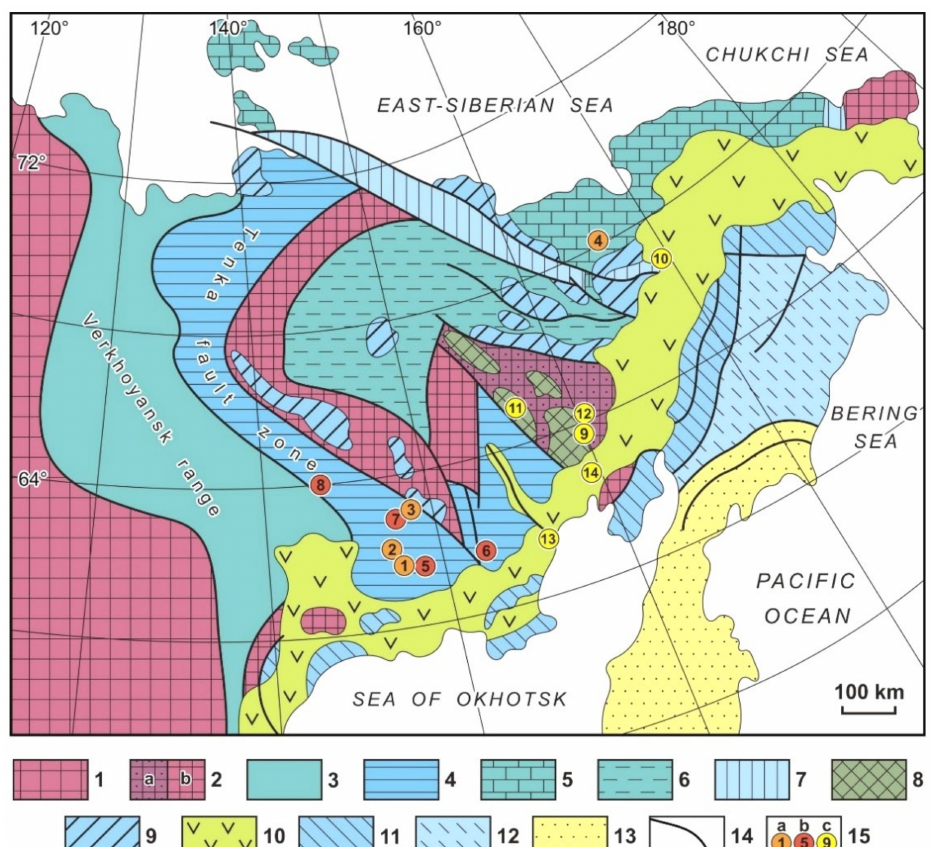
Figure 1. Location of research objects on a schematic geological and structural map of the north-east of Russia. The image was constructed by the authors of the present paper using data from